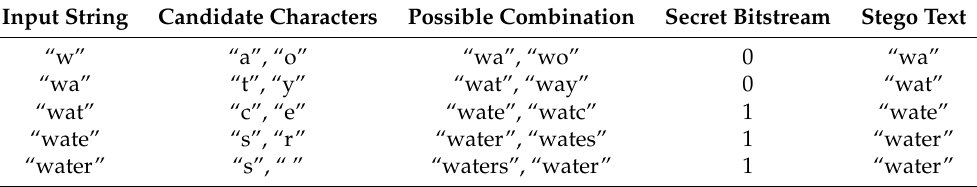
Table 2. An example of embedding a secret bitstream into the generated